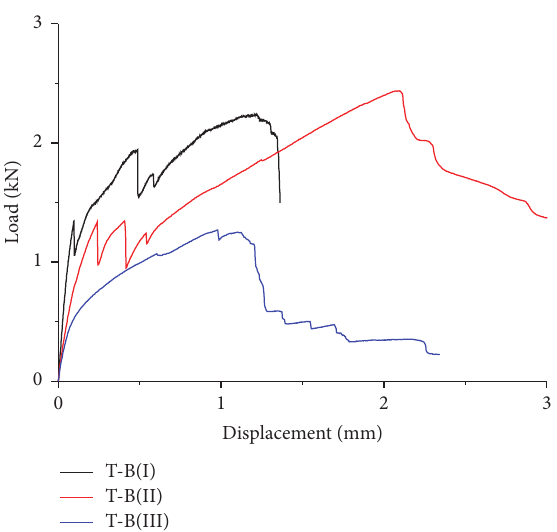
Figure 3: Bending test of thin plate.